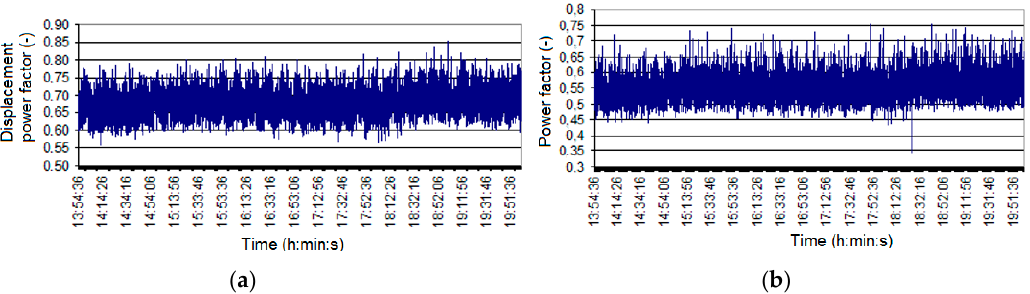
Figure 22. Power factors measurement: (a) displacement power factor (for the fundamental); (b) real power factor.